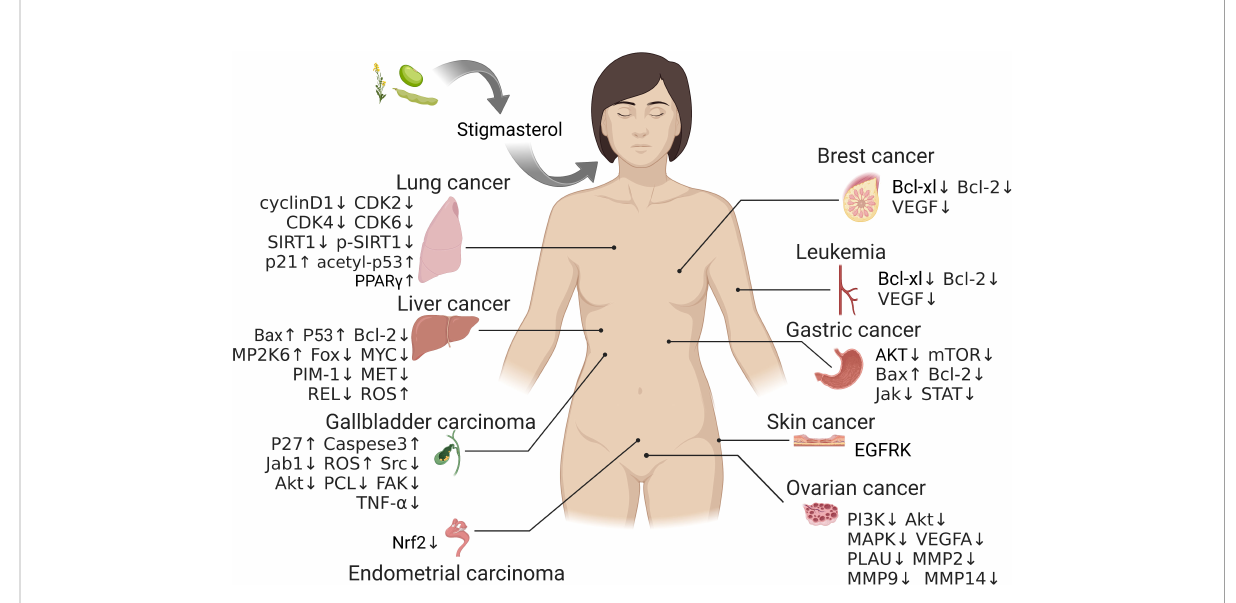
FIGURE 1 The potential targets of stigmasterol therapy in different